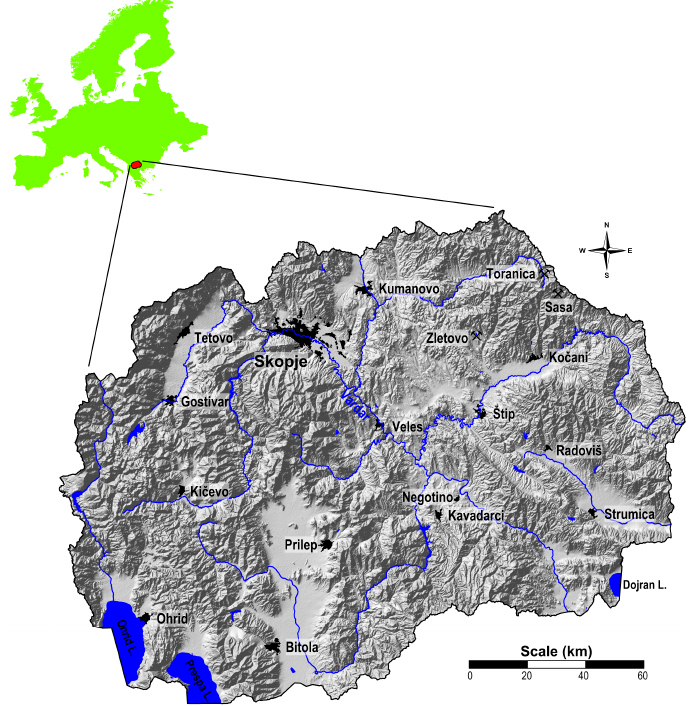
Figure 1. Map of the Republic of Macedonia.